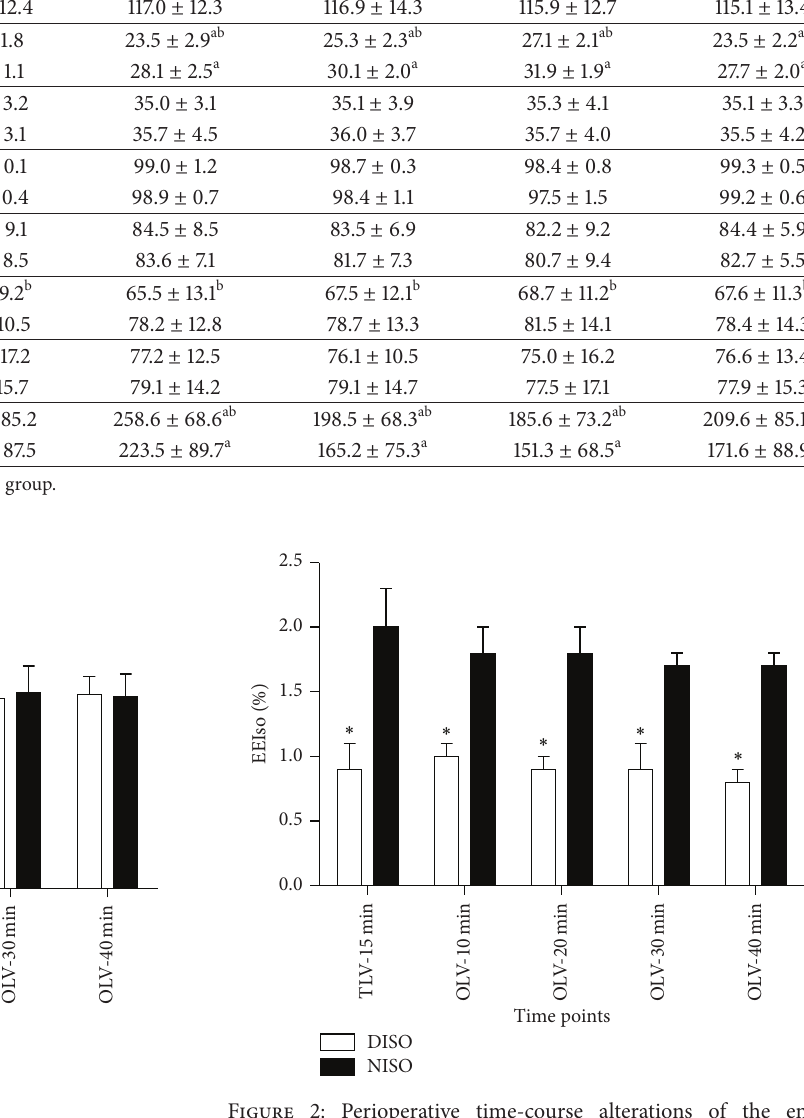
Figure 1: Perioperative time-course alterations of the bispectral index (BIS) in DISO group and NISO group. The values were measured as follows: 15min after two-lung ventilation (TLV-15), 10min after one-lung ventilation (OLV-10 min), 20 min after one- lung ventilation (OLV-20 min), 30 min after one-lung ventilation (OLV-30 min),and40 minafterone-lungventilation(OLV-40 min). Data are presented as median (interquartile range).